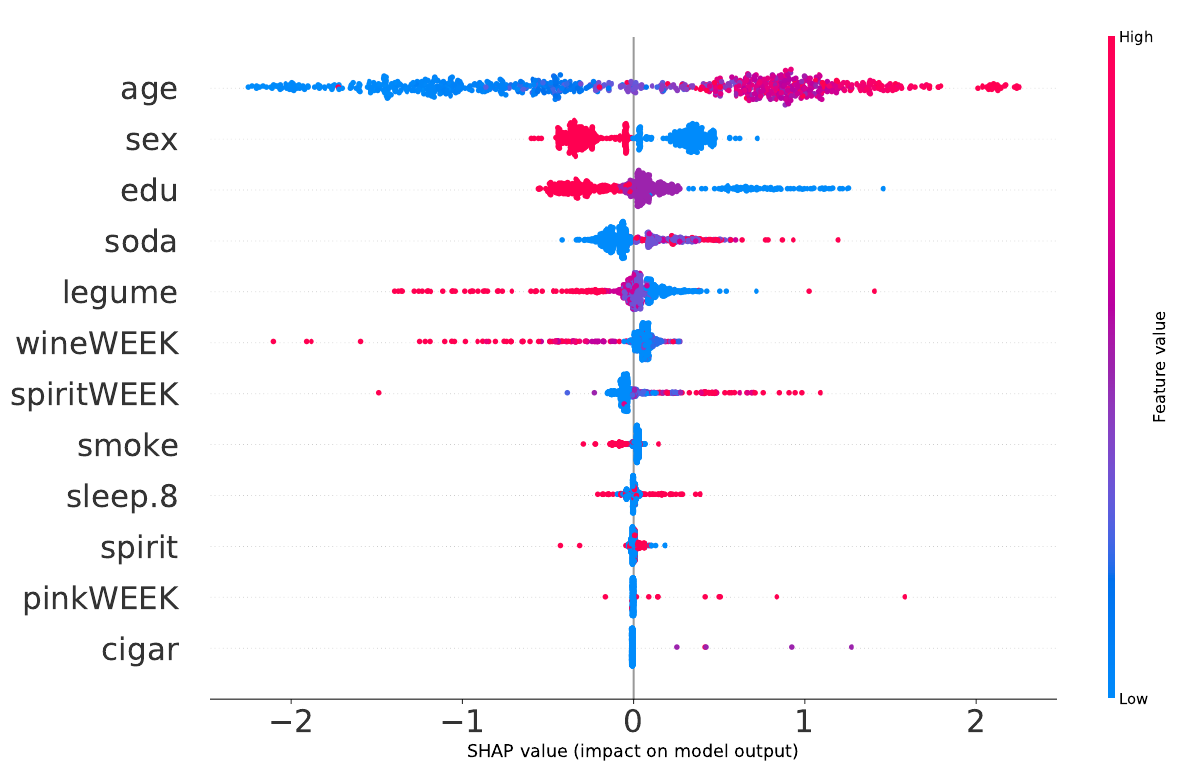
Figure 9. Impact of variables with SHAP, Gradient Boosting with Stud selection, without